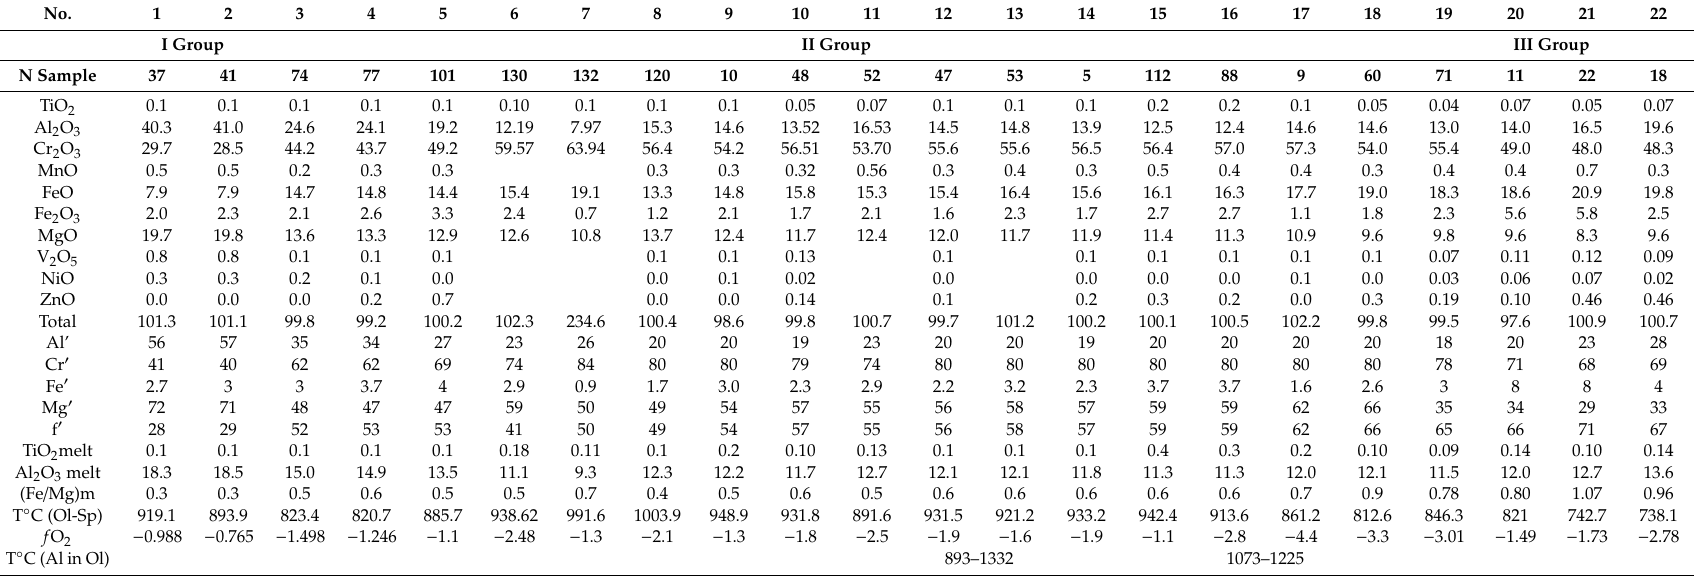
Table 1. Representative chemical composition of Cr spinels and the calculated parental melt composition (wt. %) of Cr spinels. Thermometric and oxybarometric data for Cr